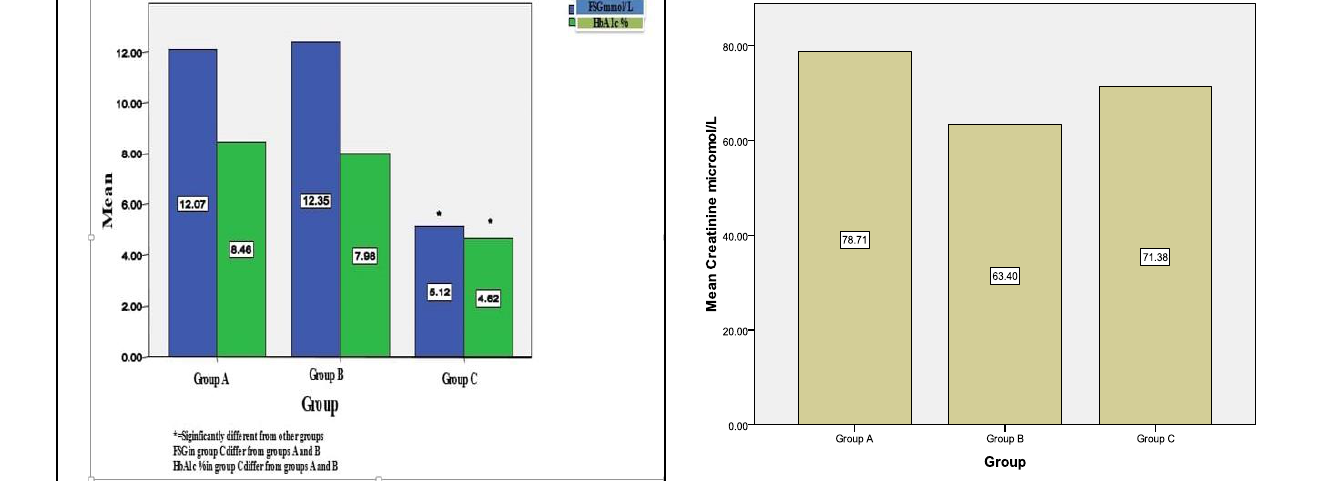
Figure (3) Mean values of serum creatinine level in: Group A =Diabetic positive microalbuminuria. Group B =Diabetic Negative microalbuminuria. Group C =Control .